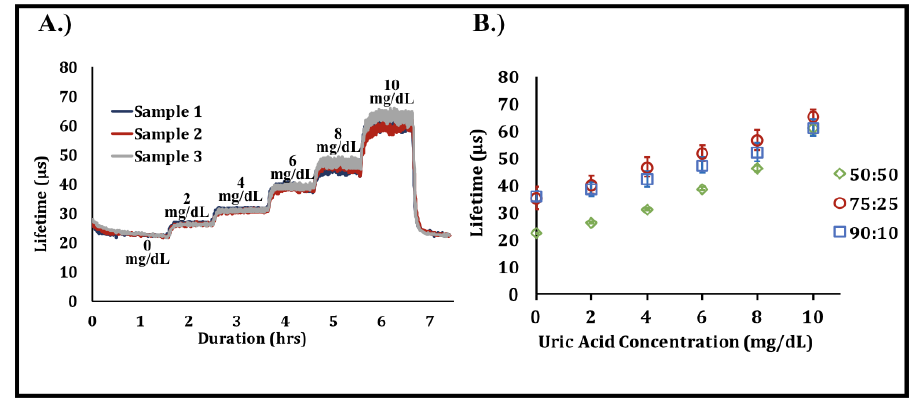
Figure 5. Effect of urate concentration on phosphorescence lifetime. ( A ) Raw data illustrating the change in phosphorescence lifetime over time with increases in urate concentration. Data are representative of a typical urate response profile obtained from a single test [n = 3 samples, 50:50 poly(HEMA-co-AAm)]. ( B ) Urate responses obtained from the three different hydrogel urate biosensor compositions. Each data point represents a steady-state average of n = 3 samples of the sample composition. Error bars represent 95% confidence intervals.